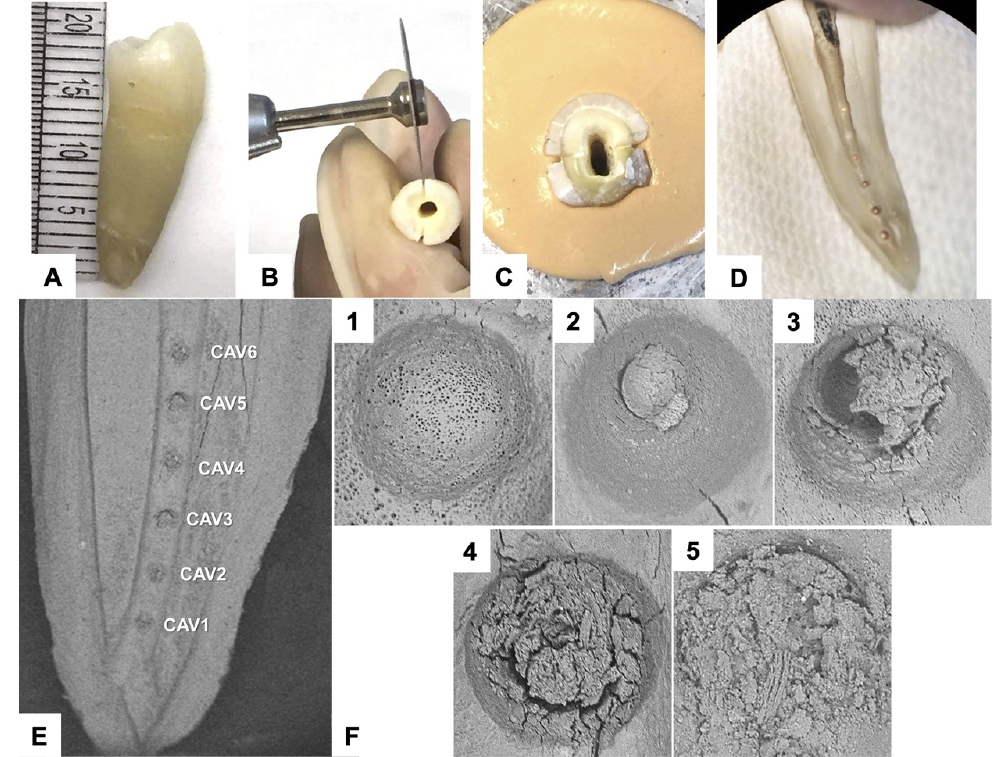
Figure 1. Step-by-step preparation. ( A ) Tooth selection. ( B ) Initial section. ( C ) Tooth embedding. ( D ) Final aspect of the cavities. ( E ) Representative SEM image of the cavities. All hemispherical cavities shown are 1 mm apart. ( F ) Representative images of scores (1, 2, 3, 4, and 5). The specimens were washed for 1 min in running water to remove the debris,